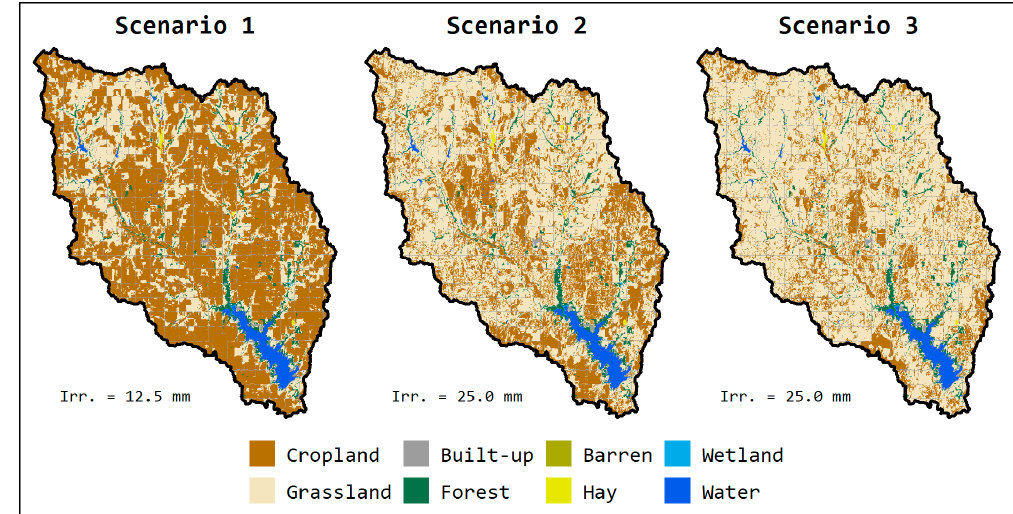
Figure 3. Land cover distribution for the proposed land use scenarios.